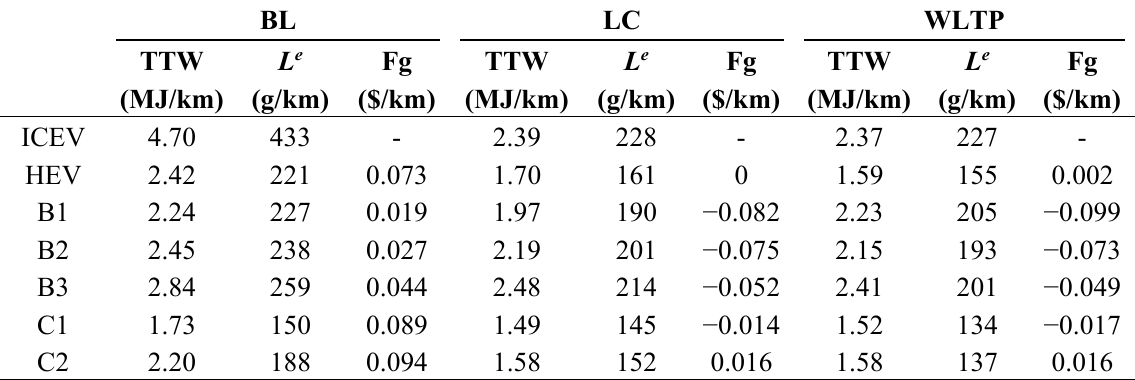
Table 11. Fuel consumption (TTW), LCA CO 2eq emissions, and financial gain of the reference vehicles (ICEV and HEV) and optimal solutions for BL, LC and WLTP driving cycles. (bold values indicate a solution optimized for that specific cycle).